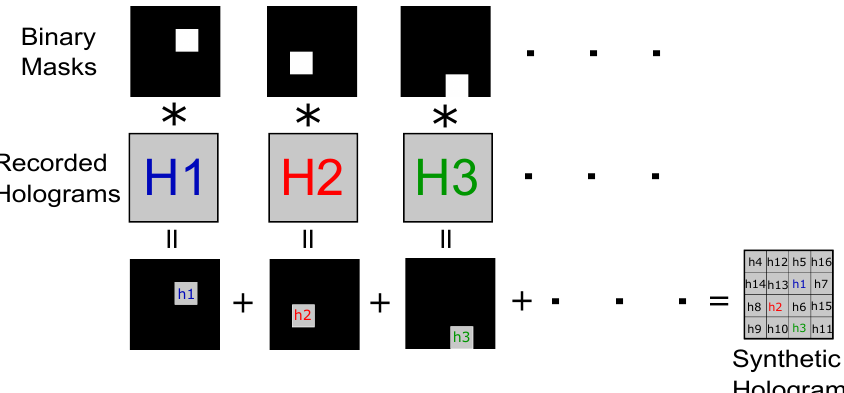
Figure 4. Digital resampling of the recorded holograms for b = 16, h = 20. Adding the individual Hadamard multiplications between holograms and binary masks produces a synthetic hologram. A hologram H1 contributes the small patch h1 to the final synthetic